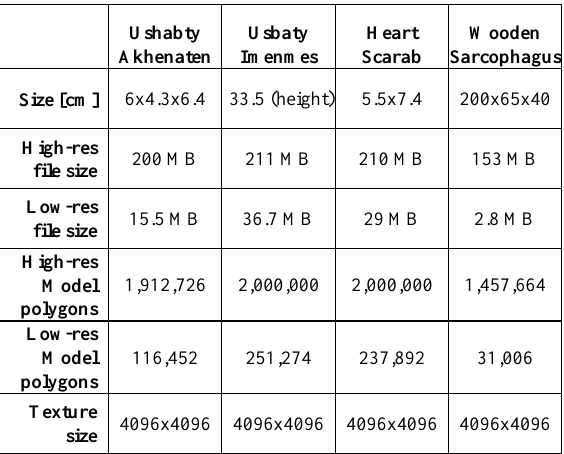
Table 1. Differences between the high and low-resolution 3D models of each artefact.